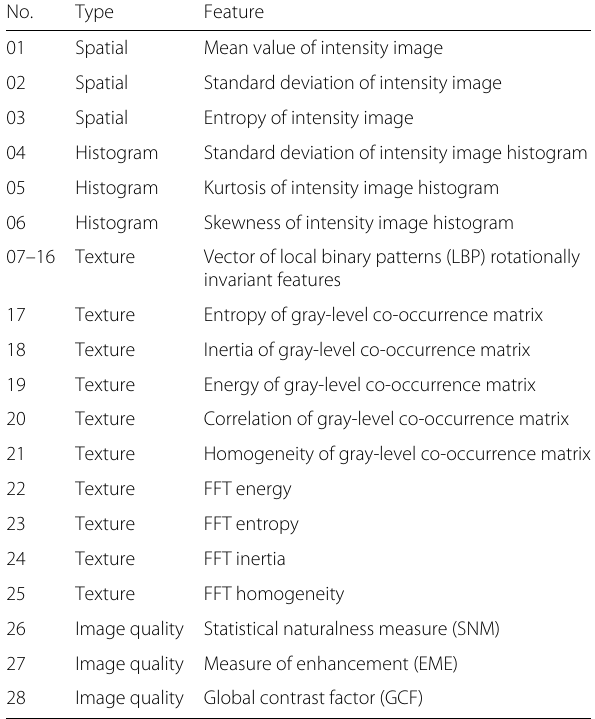
Table 2 List of all image features extracted